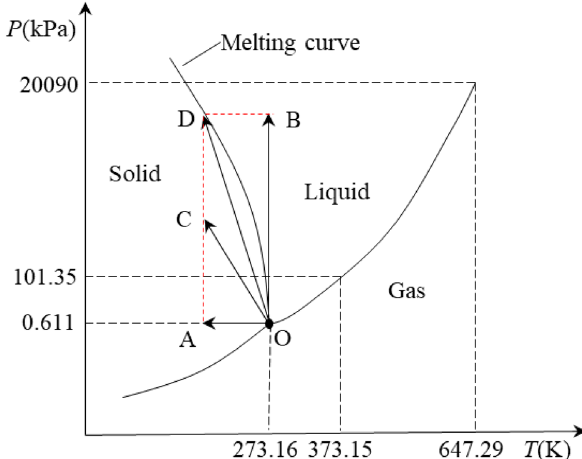
Figure 4. Three-phase graph of water.